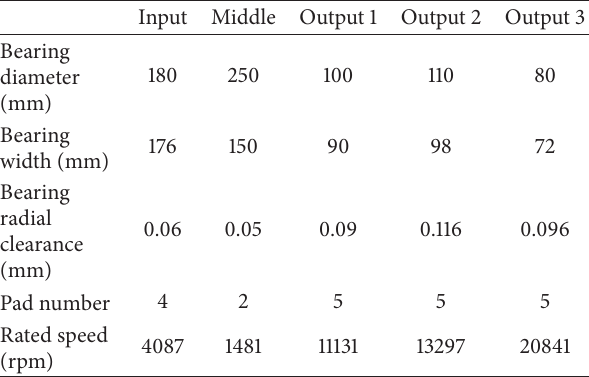
Table 3: Bearing parameters of five